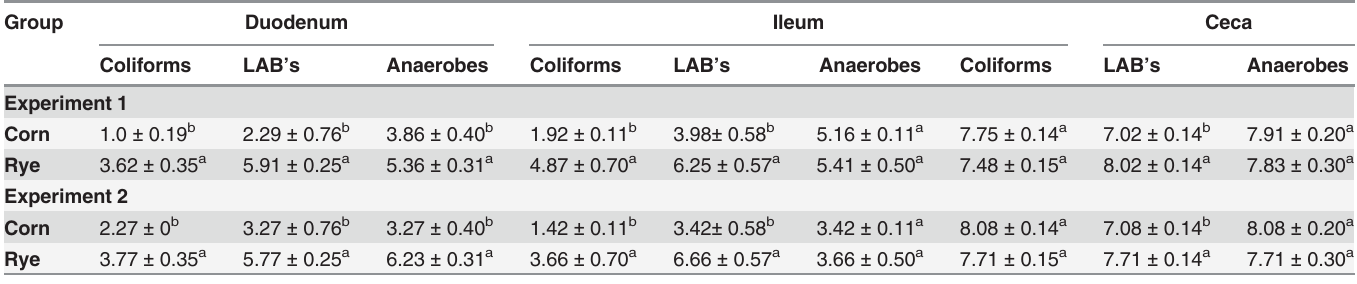
a-b Superscripts within columns indicate signi fi cant difference at p < 0.05 Data is expressed in Log 10 cfu /g of tissue. Mean ± SE from 12 turkey